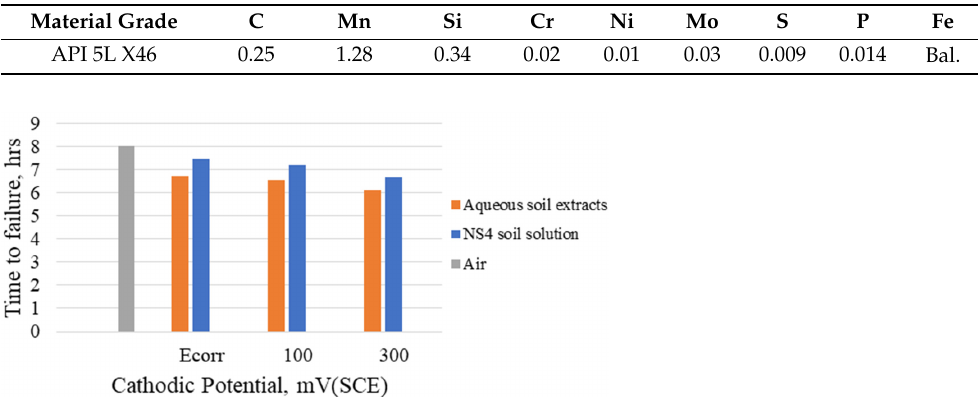
Table 9. Standard chemical composition of NS4 (near-neutral synthetic soil) solution [50]. Reprinted with permission from [50], 2012, Elsevier. Table 10. Chemical composition of X46 carbon steel (wt.%) [15]. Reprinted with permission from [15], 2014, Elsevier. Material Grade